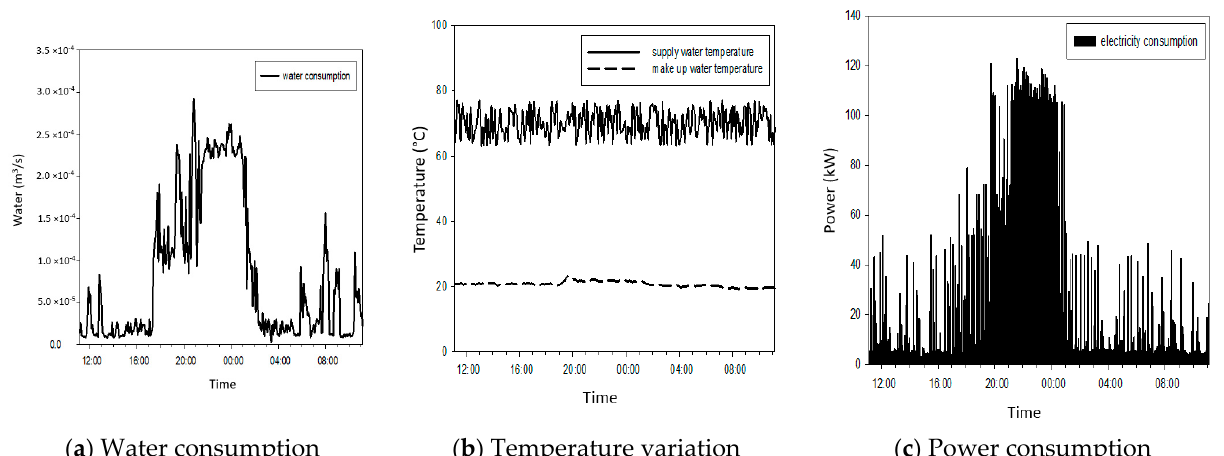
Figure 3. Electrical heater water heating system.